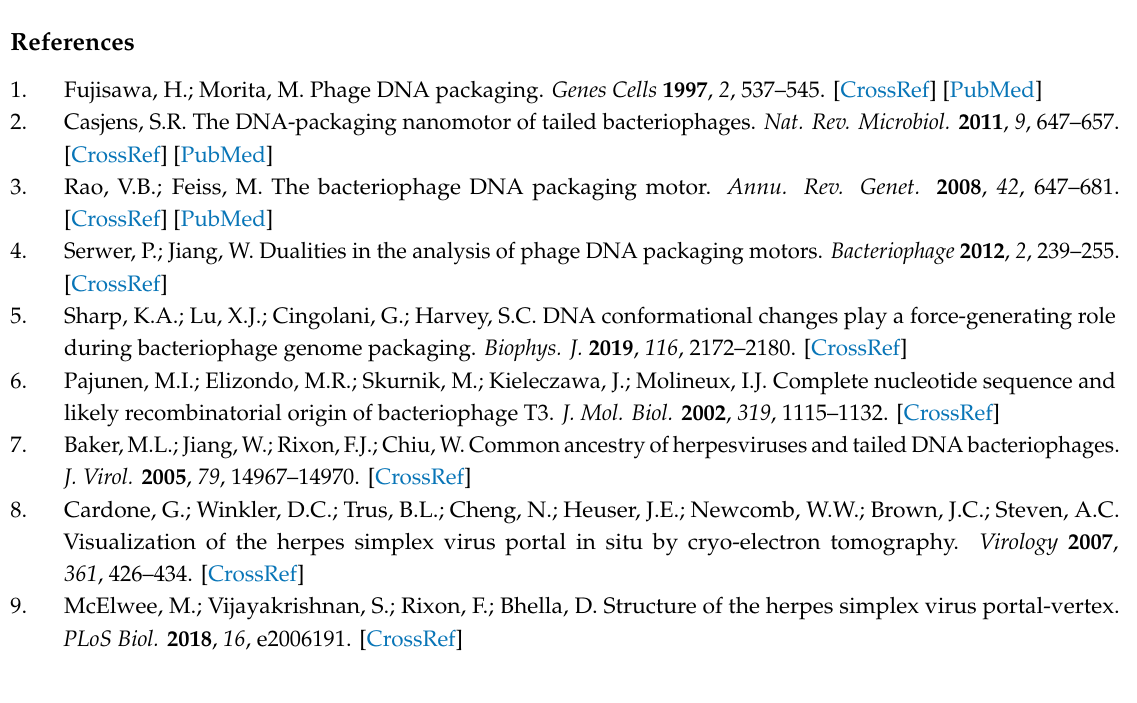
Figure S1: Unsegmented version of Figure 1, an image obtained by EM-TS of a phage T3